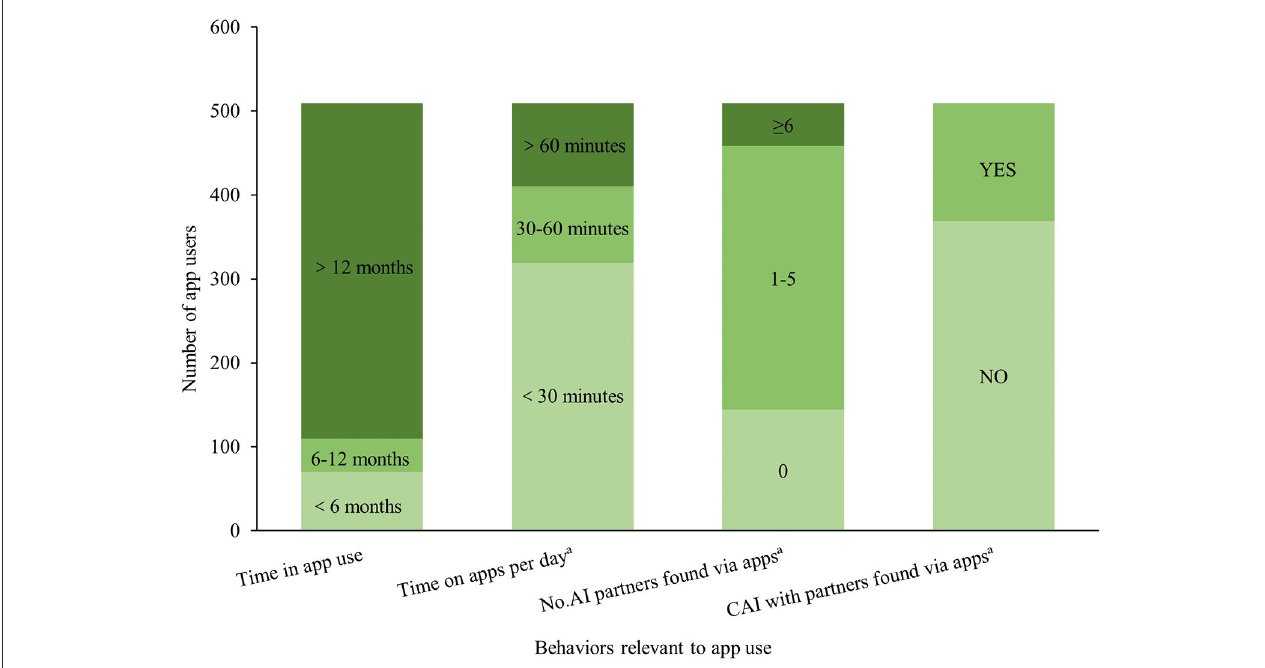
TABLE 2 STIs of GSN app users and non-app users ( N = 572).